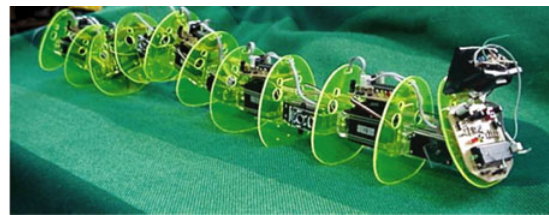
Figure 1 Mechanical structure of ANA II.